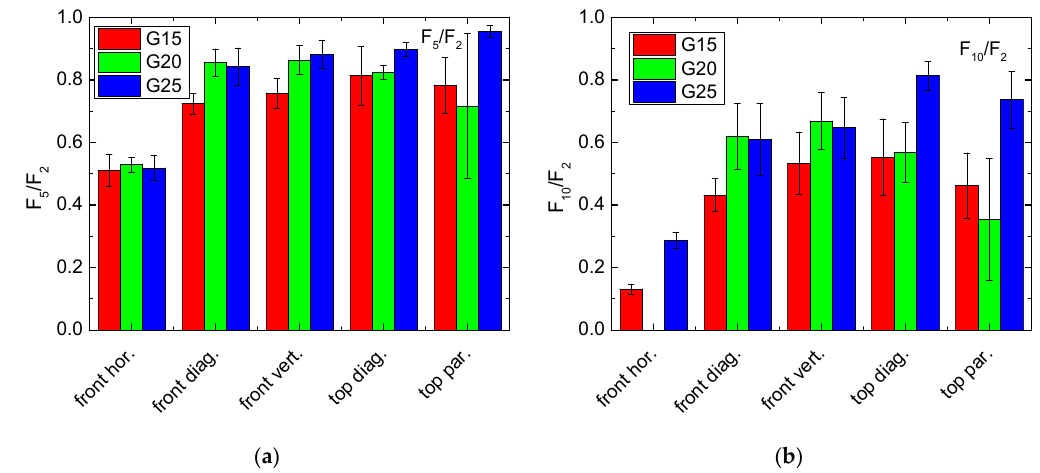
Figure 6. Force quotients of the samples under investigation, related to the force measured along an impact of 8–10 mm during the second cycle: ( a ) F 5 /F 2 ; ( b ) F 10 /F 2 .